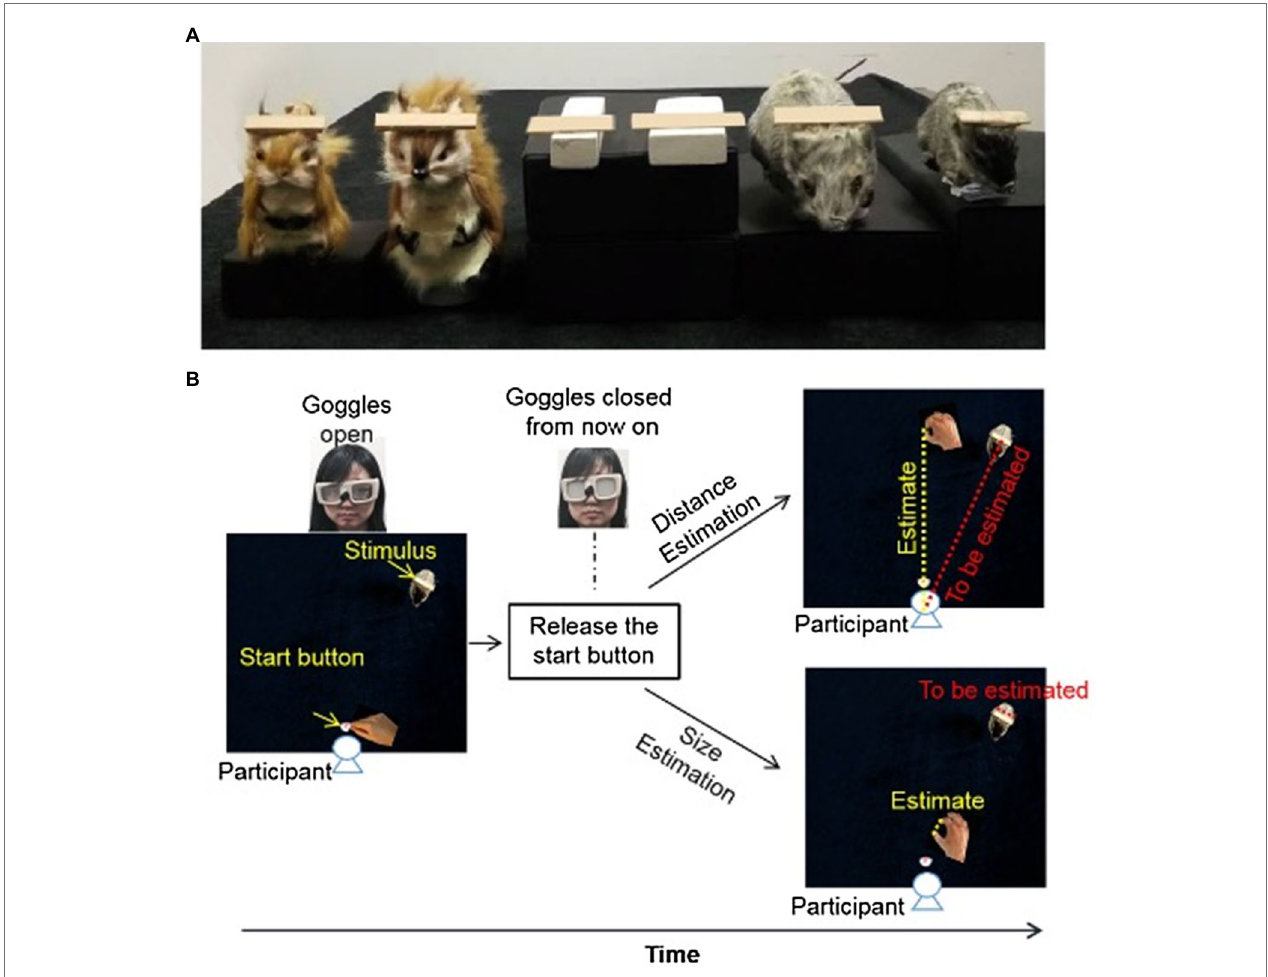
FIGURE 1 | Stimuli and layout of the setup of Experiment 1. (A) Toy rats, toy squirrels and wooden blocks with wooden plaques (target objects) resting on them. (B) At the beginning of each trial, the goggles were closed. Participants were asked to hold down the start button before the task. After the experimenter opened the goggles, participants indicated the perceived distance (up) or the perceived size (bottom) of the target object. For both distance and size estimation, the goggles were closed as soon as the participants released the start button (i.e., open-loop) to prevent any online visual feedback during the